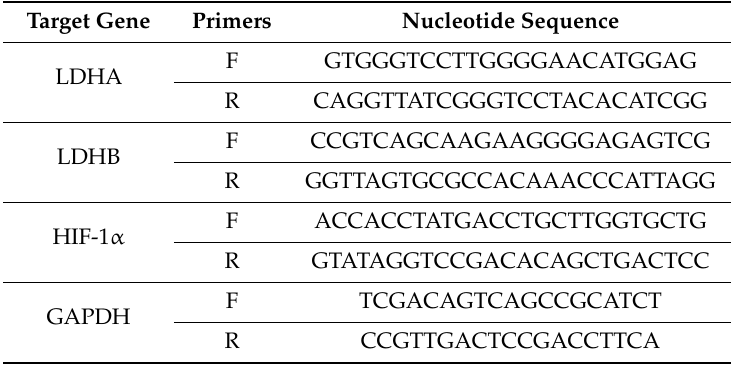
Table 2. List of primer sequences used in PCR